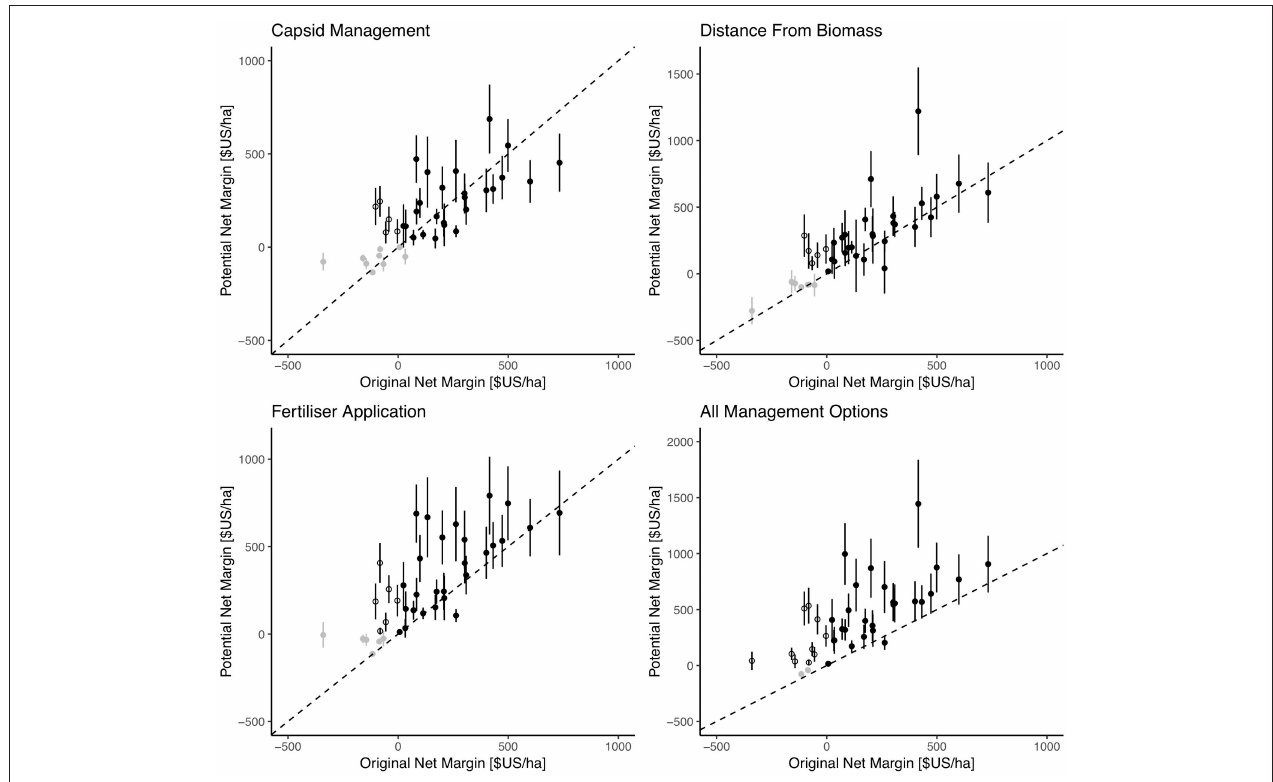
FIGURE 3 | Comparison of current and potential net margins. Net margins were calculated for each farm (see Materials and Methods for details) for monitored yields and reported fixed and variable costs and compared to modeled yields and input costs for each factor explored. Gray points indicate farms where net margins remained negative after yield increases and hollow points indicate farms that went from negative to positive net margins. Dotted lines represents 1:1. The assumed exchange rate was US$ 1 to GHS 4.5.